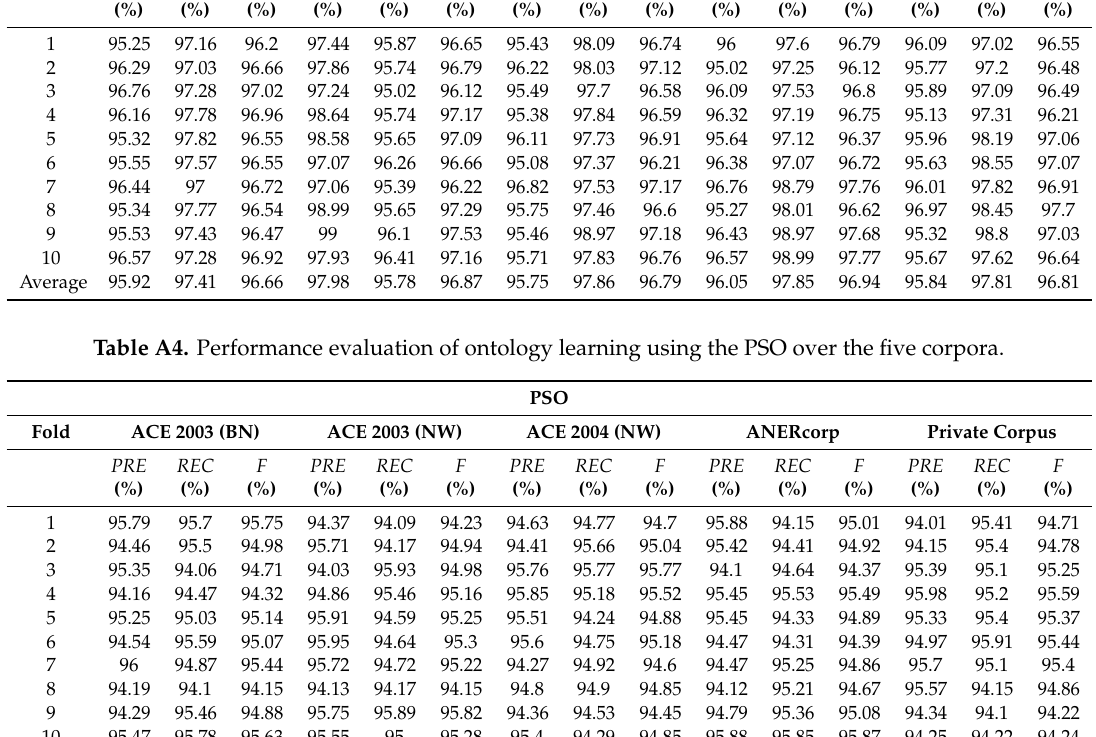
Table A3. Performance evaluation of ontology learning using the WOA over the five corpora. Fold